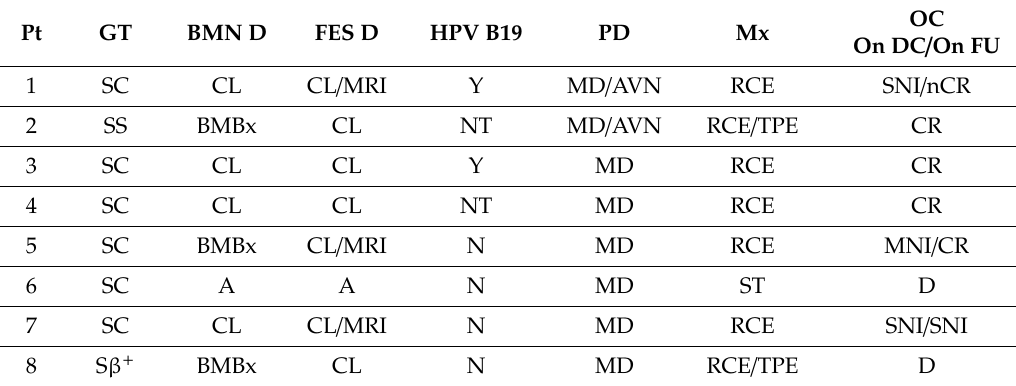
Table 1. Patient characteristics, management and